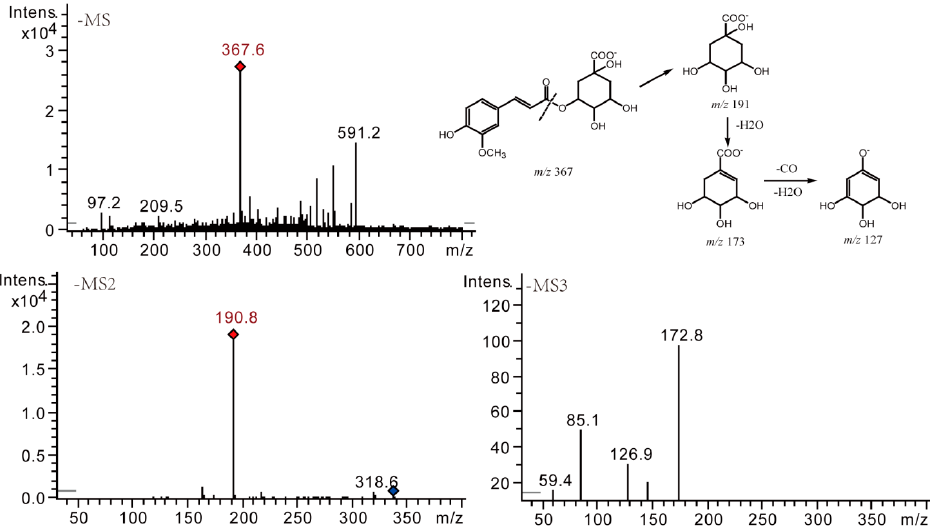
Figure 9. Negative MS n spectra and proposed fragmentation patterns of compound 2 .